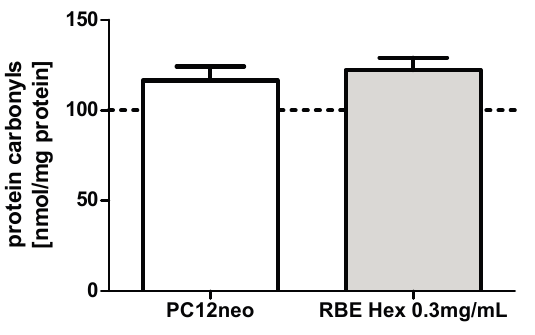
Figure 3. Protein carbonyl concentrations in PC12 cells after 24-h incubation with 0.3 mg/mL hexanic rice bran extract (RBE) or the respective DMSO control; cells treated with cell culture medium served as control for normalization (100%); n = 8; mean ± SEM.